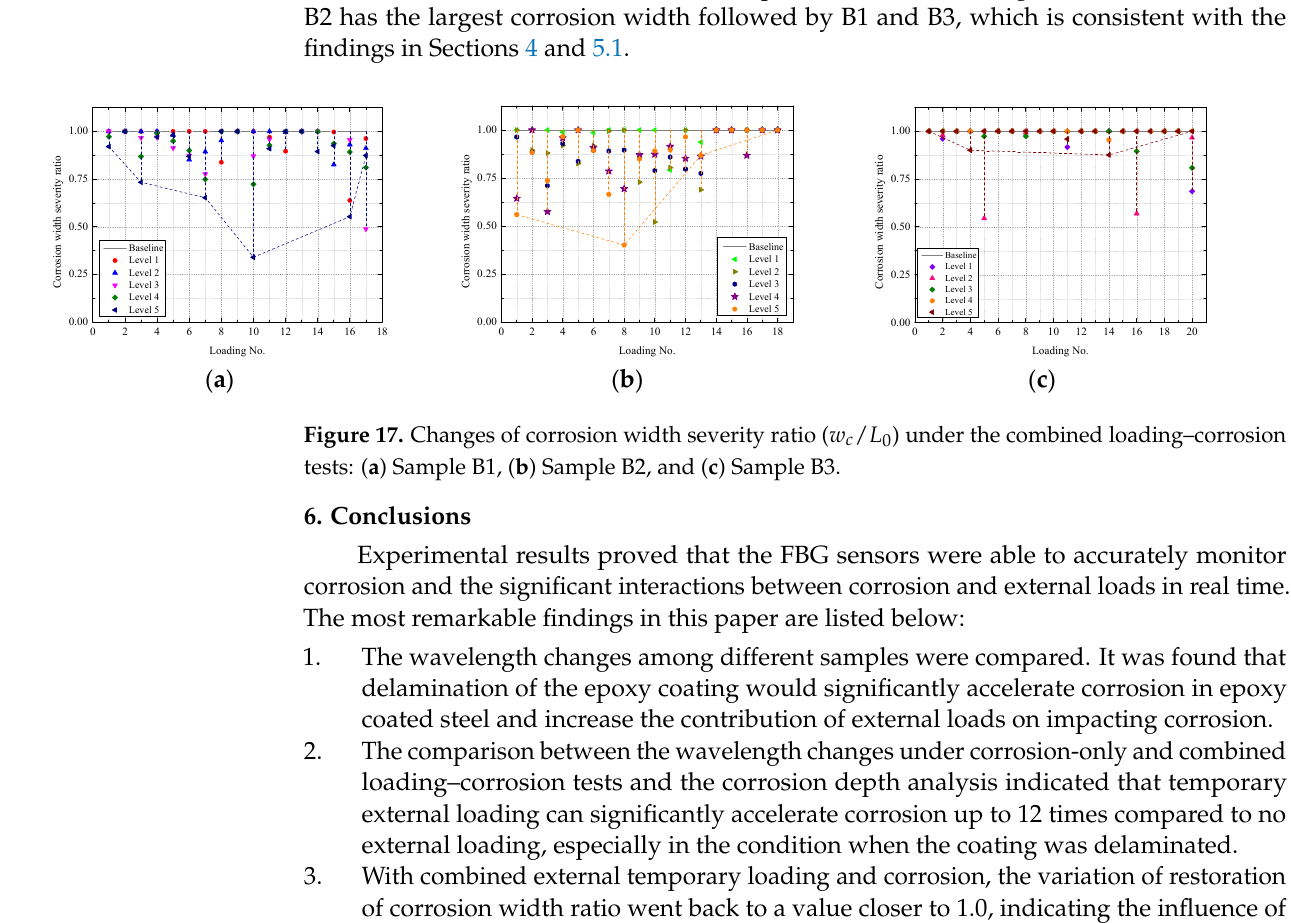
( d ) Figure 16. Comparison corrosion depth severity ratio: ( a ) Sample B1-C1, ( b ) Sample B2-C2, ( c ) Sam- ple B3-C3, and ( d ) Corrosion depth severity with impact from external temporary loads. 5.2. Corrosion width Severity Ratio According to Equation (13) and the monitored Bragg wavelength changes in Figures 15 and 17a–c, which show the changes of corrosion width severity ratio, which is defined as dividing the actual corrosion width ( 𝑤 (cid:3030) ) by the initial assumed corrosion width (L 0 ), under the combined loading–corrosion tests of the three tested samples with five different loading levels. As the original width of corrosion is unknown, in this study, the original width of the corrosion ( 𝐿 (cid:2868) ) is assumed to be the diameter of the external load which equals to 0.75 in. (diameter of the loading rod) in this experiment. As the actual corrosion width usually is less than the diameter of the external load (0.75 in.), the corrosion width severity is expected to be a value of less than 1.0. The accumulation of corrosion products under FBG sensors induce an upward lift leading to the increase of the corrosion width, and as the corrosion grows more severe, the corrosion width is expected to be comparable and